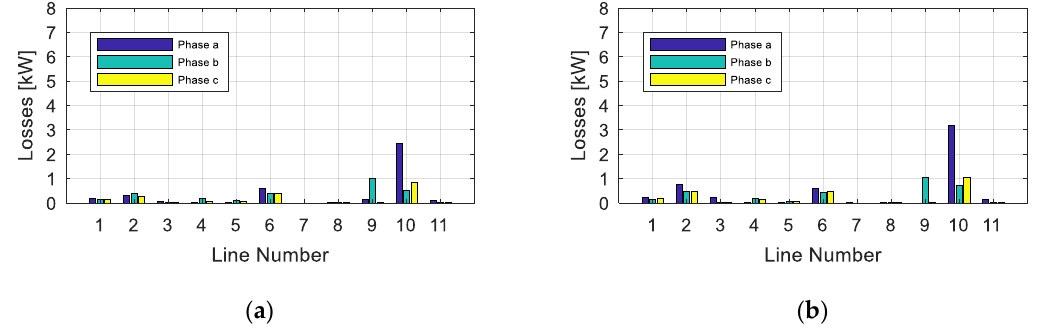
Figure 8 . Scenario 0: Line losses at the hours: ( a ) Peak-H and ( b ) Peak-L.